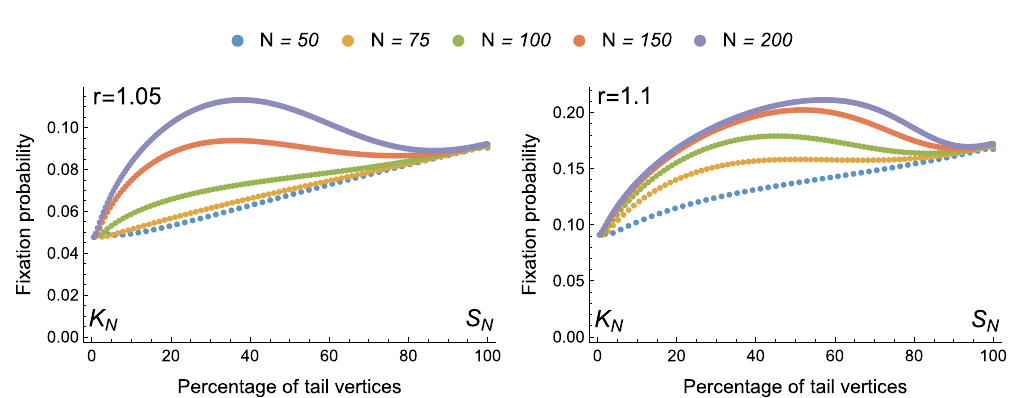
Figure 1. The Comet graph C Nm consists of a Clique K m and a Star S N − m + 1 graph.